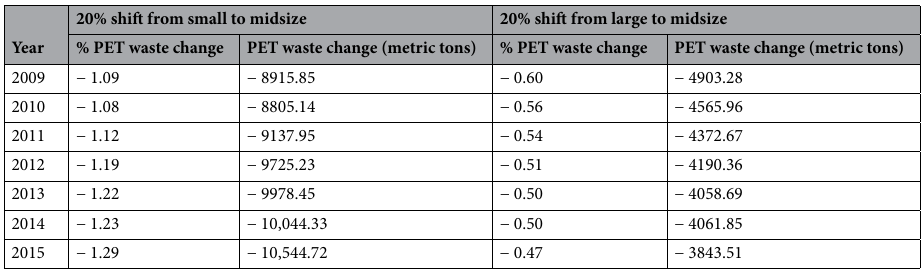
Table 3. Projected PET waste reductions from shifting 20% of beverage consumption in small or large bottles to midsize bottles in the United States. Projections are based on actual beverage sales figures at the national level and hold constant the total number of ounces of beverage sold in each product